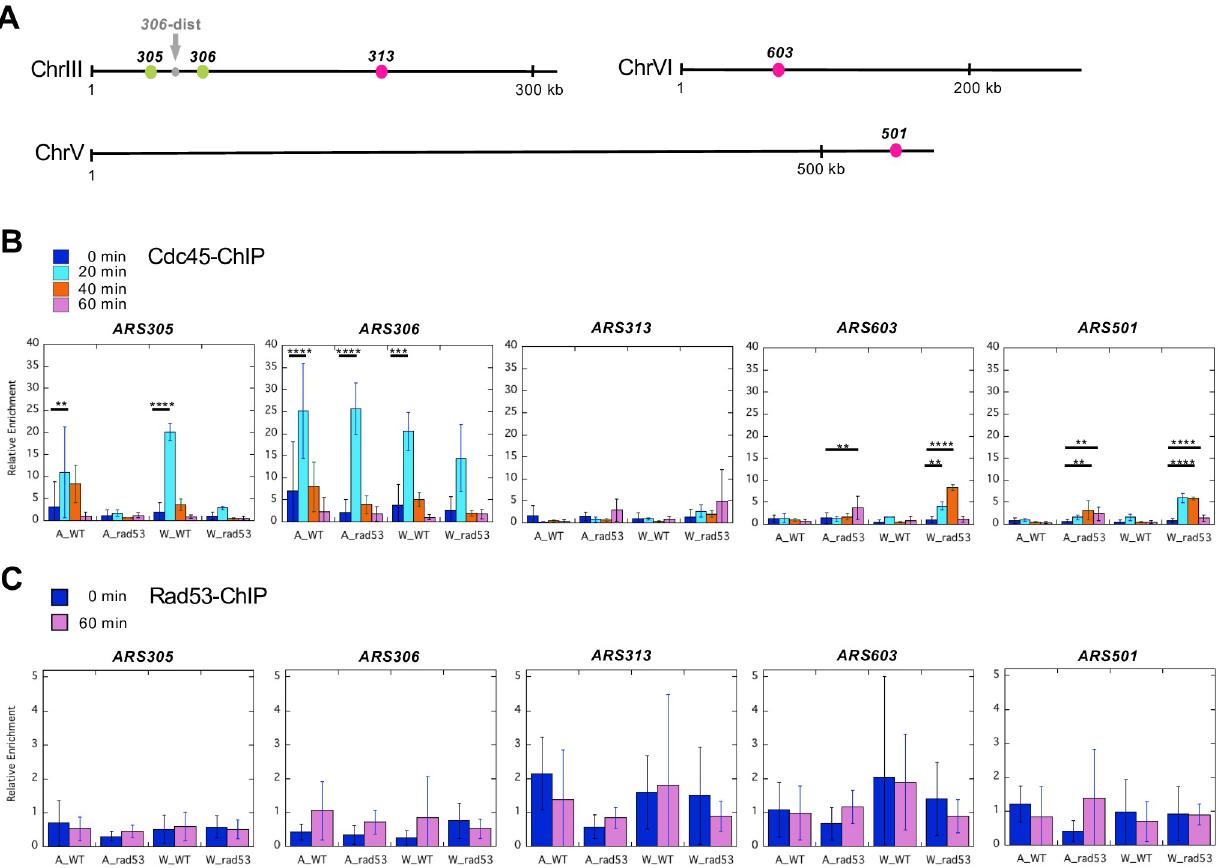
Fig 3. ChIP-qPCR analysis of initiation factor binding to origins. (A) Schematic diagram (drawn to scale) of the chromosomal loci used for qPCR analysis. The prefix “ARS” was dropped for simplicity. Note the ARS306-dist locus that is located 20 kb upstream of ARS306 and 15 kb downstream of ARS305 was used as a negative control region to normalize signals from all other loci. (B) Cdc45-ChIP was performed in cells collected at 0, 20, 40, and 60 min post release of G1-arrested cells into S phase in the presence of 200 mM HU. "A", A304a; "W", W303. Relative enrichment of the ChIP DNA signals was calculated as the ratio of %Input at a given locus over %Input at the control locus. %Input was calculated as the percentage of ChIP-DNA in input DNA, averaged from at least three replicate experiments. The error bars represent standard deviations. Statistical analysis was performed by one-way ANOVA followed by Tukey’s multiple test. � , p < 0.05; �� , p < 0.01; ��� , p < 0.001; ���� , p < 0.0001. (C) Relative enrichment of Rad53-ChIP DNA at the same loci as in (B). The analysis was done identically as in (B) except only cells collected at 0, and 60 min post G1 arrest/release were